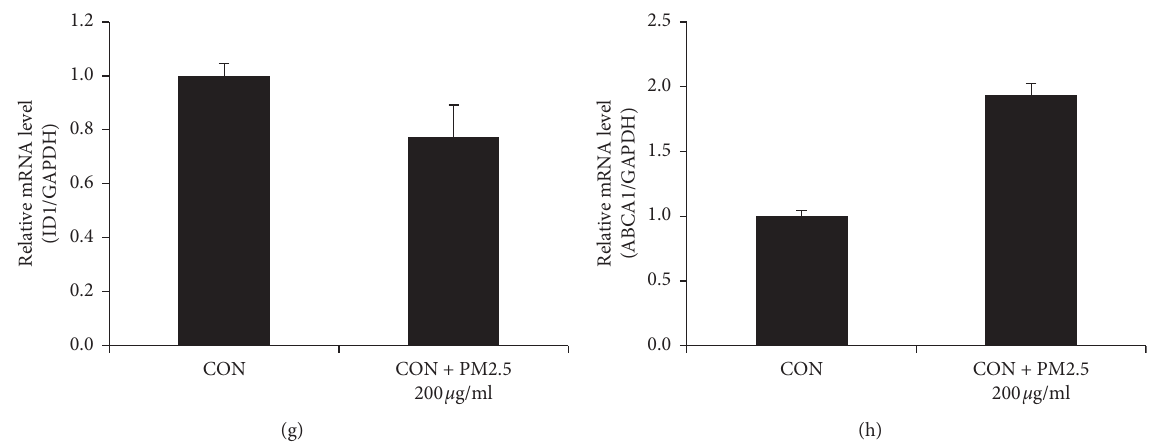
Figure 3: HaCaT cells enriched expression of ITGA3, ABCA1, CD44, IL-1 β , MMP1, and SERPINE1 while downregulated expression of EDN1 and ID1.